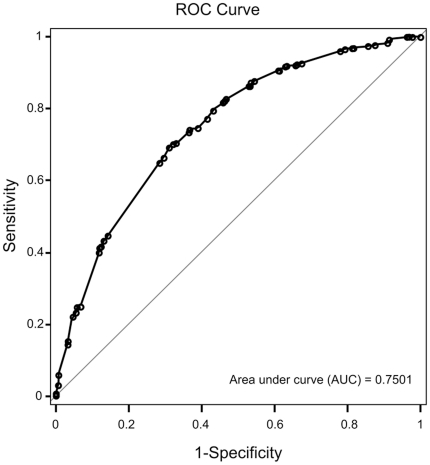
Receiver operating characteristics (ROC) curve for the logistic regression model.Disease  =  −3.6802+0.4487×B*46:01+0.8883×DPB1*05:01 – 0.3494×DQB1*03:02 – 0.492×DRB1*12:02+0.8388×DRB1*15:01+1.0727×DRB1*16:02+1.5865×Female. The logistic regression model was built based on the data from our unrelated case-control study individuals. Genotypes were coded following a dominant inheritance mode. The area under curve (AUC) of this ROC curve is 0.75.